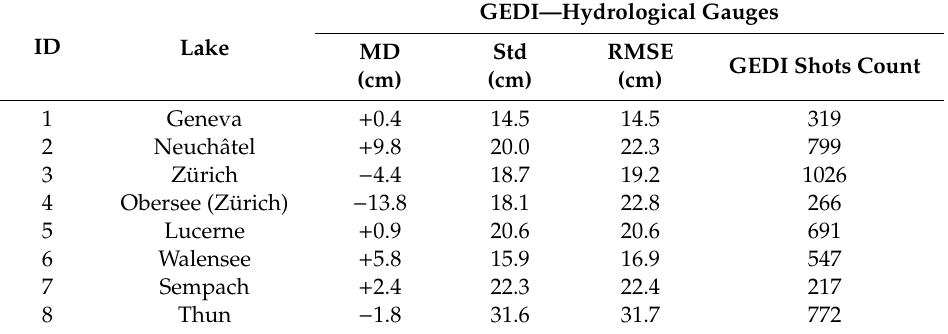
Table 3. Summary statistics of elevations from GEDI acquisitions for each of the 8 studied lakes (Mean MD, standard deviation std, and root mean square error RMSE of the di ff erence between GEDI elevations and in-situ elevations) using data from all acquisition dates given in Table 1 and from all the